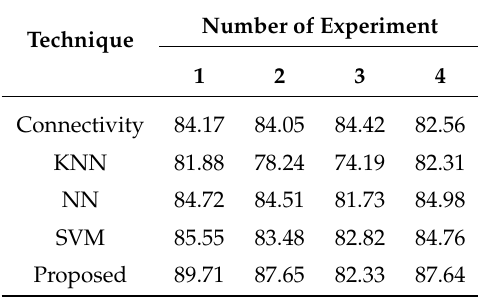
Table 4. Comparison between methods in different experiments in terms of accuracy (%).